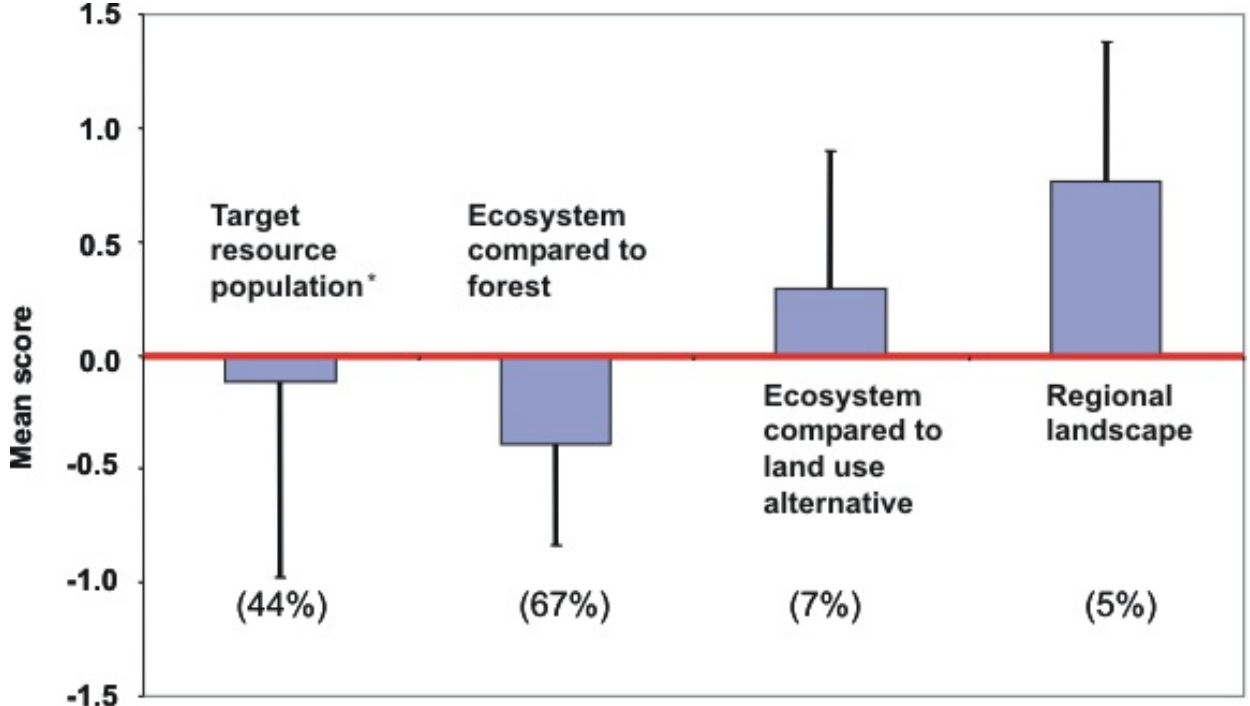
Fig. 4. Aggregated mean environmental outcomes. The bars represent the mean and the lines represent the standard deviation. The percentage of cases with a negative mean score is presented in